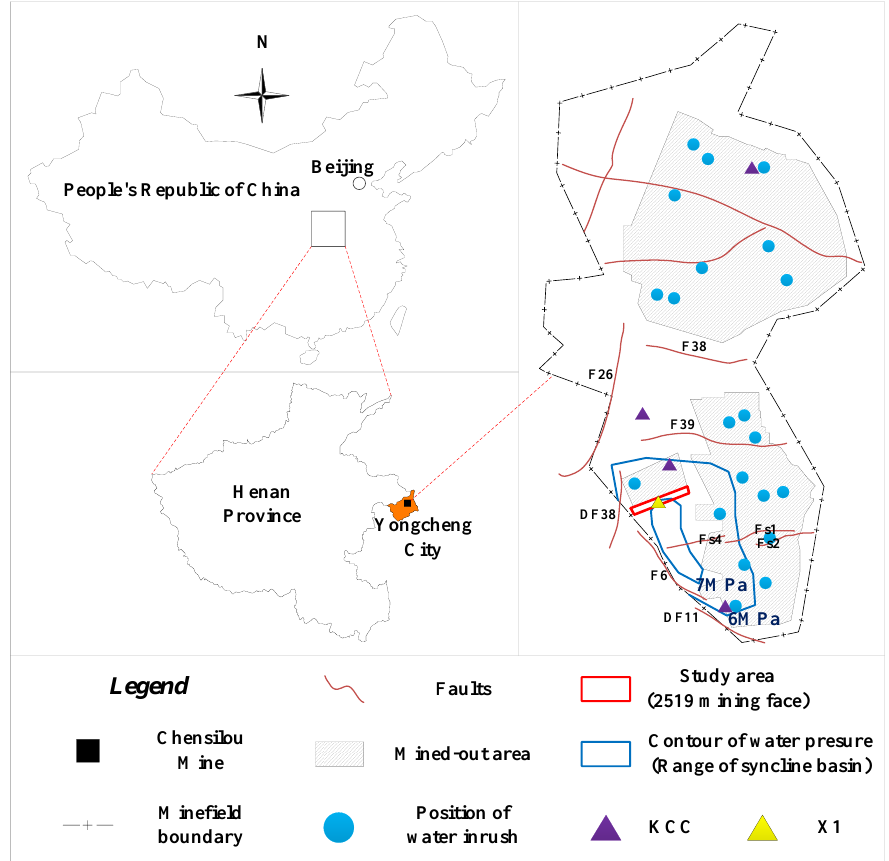
Figure 2. Location of Chensilou mine and study area.